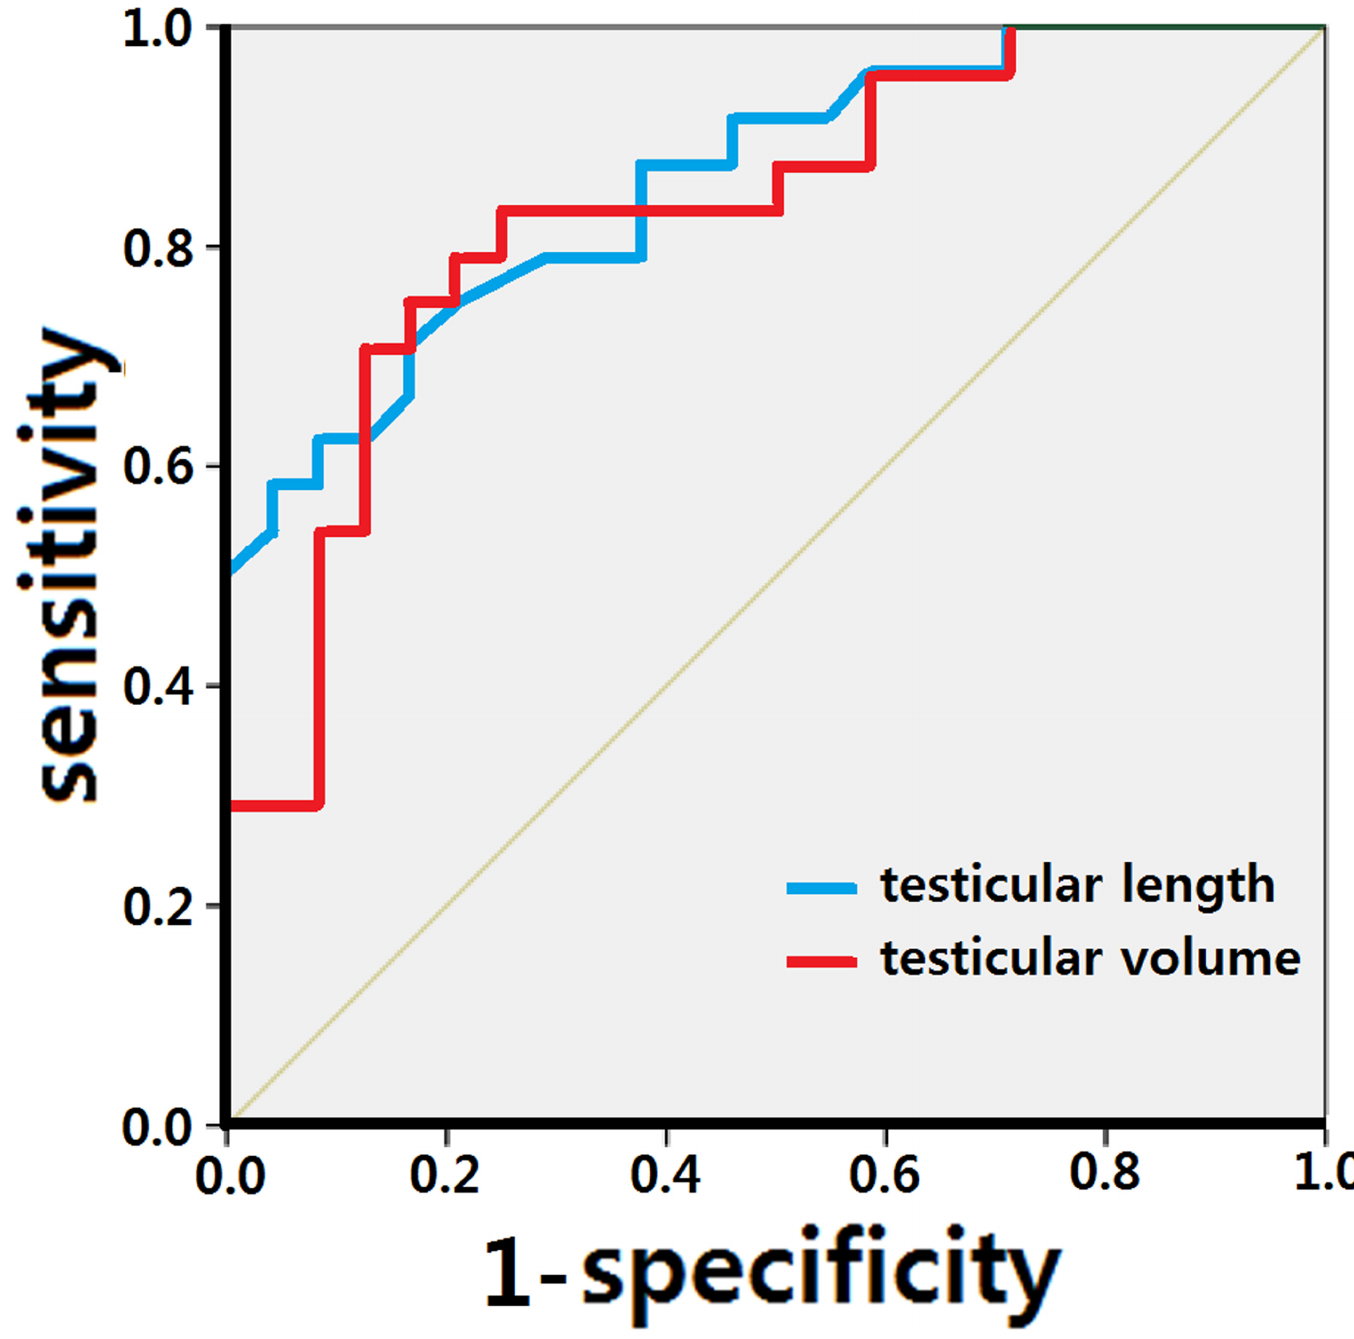
Fig 3. When testicular length was 16.1 mm (sensitivity 75.0%, specificity 79.2%) and volume was 0.59 ml (sensitivity 83.3%, specificity 75.0%), the combination of sensitivity and specificity was maximal. The area under the curve was calculated as 85.9% (95% confidence interval: 75.7% – 96.2%) for testicular length and 83.3% (95% confidence interval: 71.8% – 94.9%) for testicular